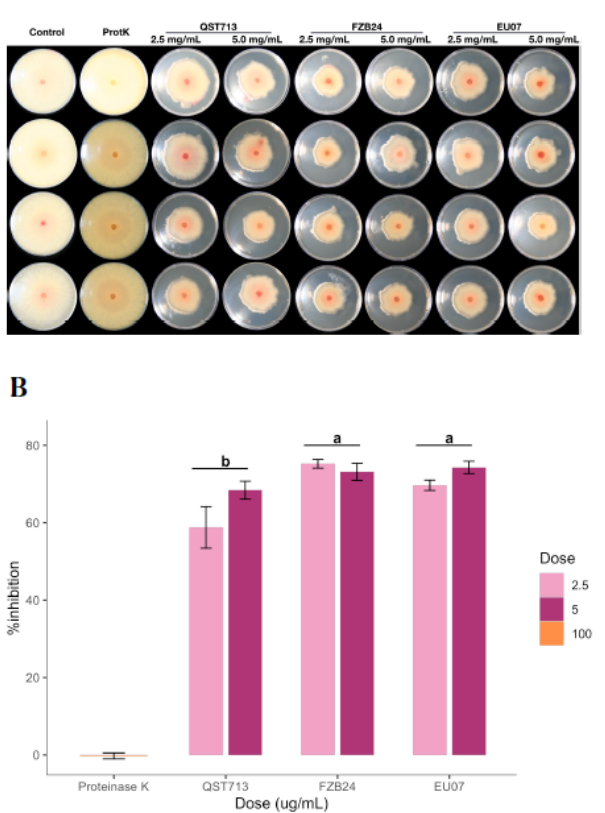
Figure 6. Antagonism assays using proteinase K treated bacterial broths. ( A ) Antagonistic effect of the bacterial broths filtered, autoclaved and proteinase K treated (100 µg/mL) of QST713, FZB24 and EU07 against Fg- K1-4 were performed on PDA/NA. Bacterial broths are shown by bacterial treatment (top, left to right) and by dosage (top, left to right). (B) Percentage inhibition of the Fg -K1-4 by the broths of Bacillus strains (24 h), adjusted to 2.5 and 5.0 mg/mL of total protein in the media. Data were from one independent experiment of four repeats and shown as the mean ± SE. Experiments were replicated two times and similar results were obtained. Bars clusters with different letters were significantly different according to Tukey’s Test ( α < 0.05) following two-way ANOVA. n =